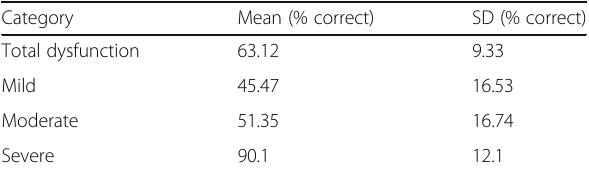
Table 5 Experiment 2: Accuracy and sensitivity for the detection task for the naïve participants viewing each movie for 2 s ( n = 30)